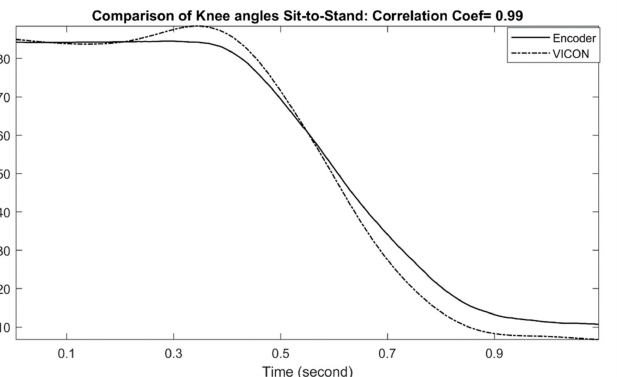
Figure 10. Comparison of Exo-skeleton’s knee angle measurement with reference motion capture during sit-to-stand. In this data, the correlation coefficient was calculated at